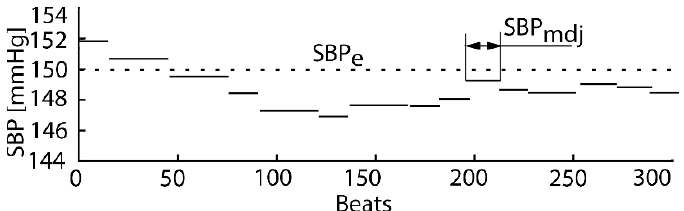
Figure 13. Estimated SBP e blood pressure value (dot line) and SBP mdj in BPEW (stepwise line).